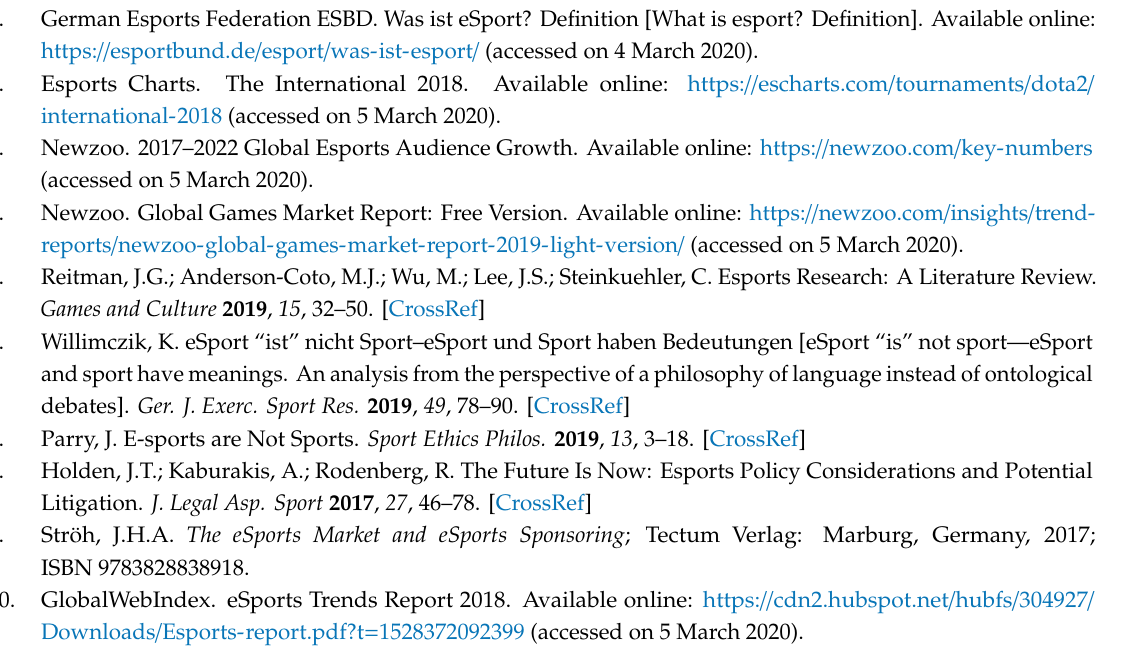
Table S1: E ff ect sizes of the statistically significant di ff erences regarding demographics and health